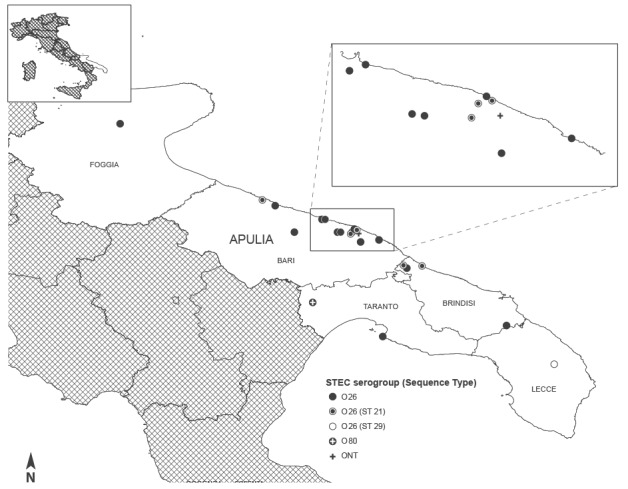
Geographical distribution of recorded cases of haemolytic uraemic syndrome, Apulia region, Italy, 1 June to 30 September 2013 (n=22)